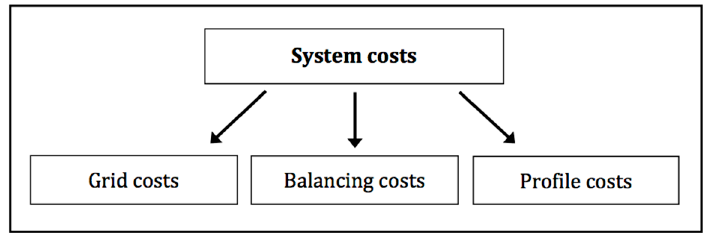
Figure 3. Three components of system costs. Sources: Based on [50,51].